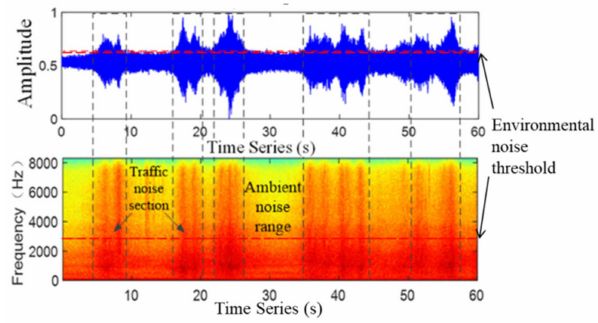
Figure 6. Waveform of traffic noise signal and its